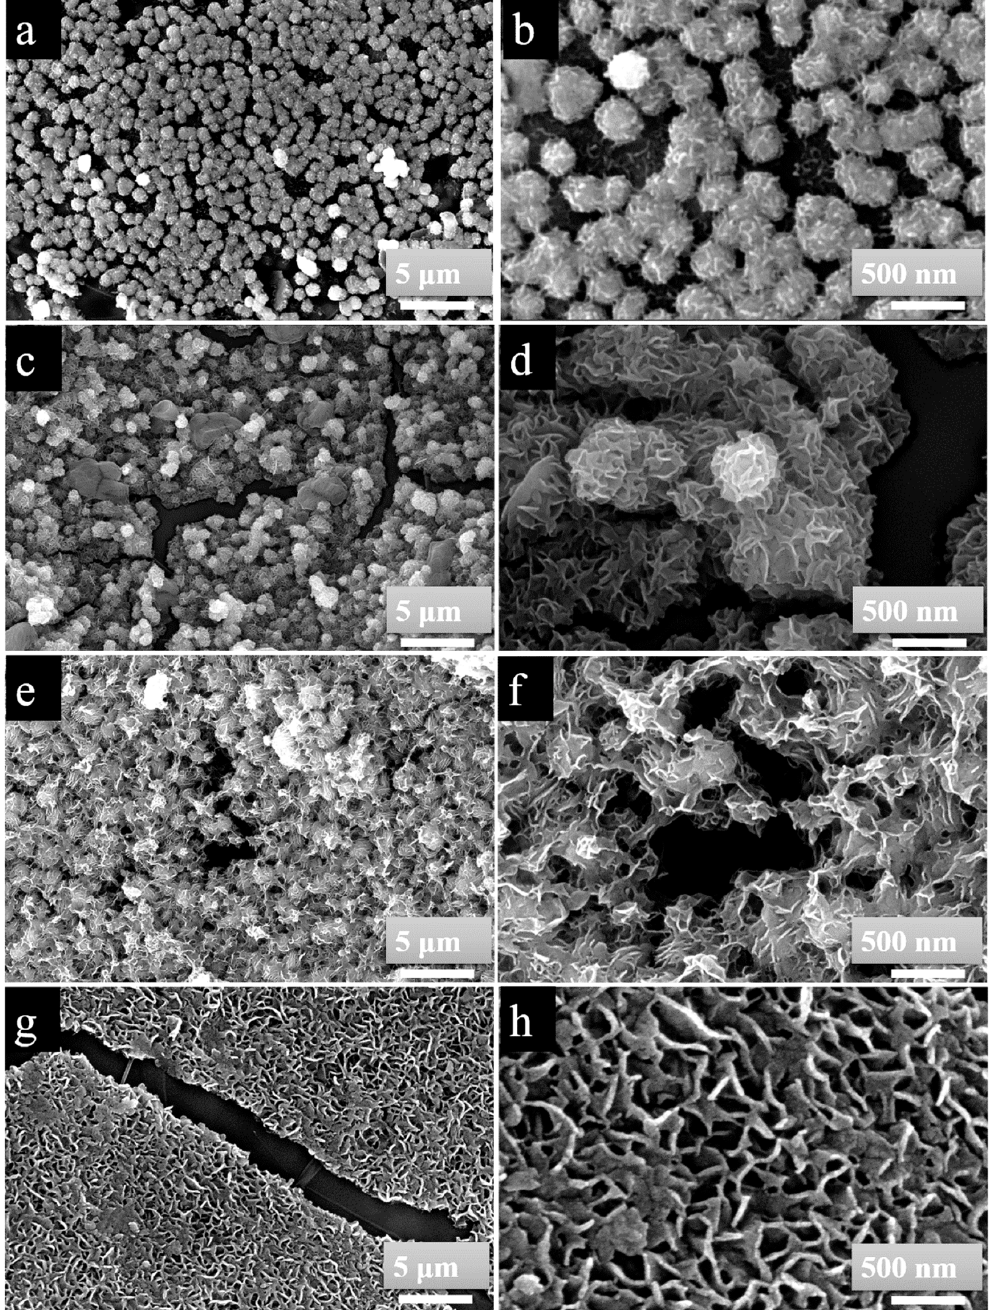
Figure 3. FE-SEM images of GNPs@Ni composite ( a , b ), GNPs@Ni x S y @MoS 2 -1 composite ( c , d ), GNPs@Ni x S y @MoS 2 -2 composite ( e, f ), and GNPs@Ni x S y @MoS 2 -3 composite ( g , h